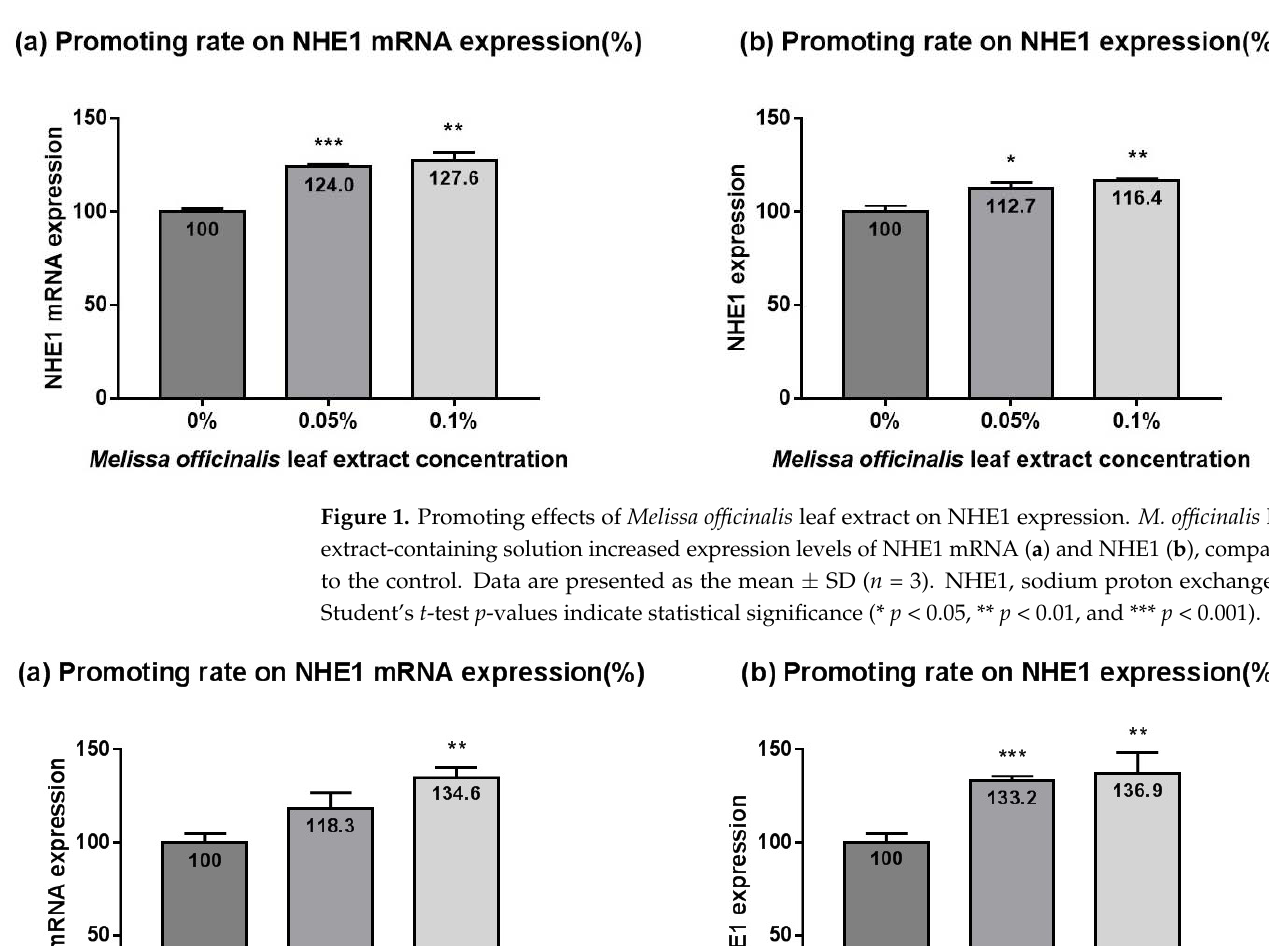
Figure 1. Promoting effects of Melissa officinalis leaf extract on NHE1 expression. M. officinalis leaf extract ‐ containing solution increased expression levels of NHE1 mRNA ( a ) and NHE1 ( b ), com ‐ pared to the control. Data are presented as the mean ± SD ( n = 3). NHE1, sodium proton exchanger 1. Student’s t ‐ test p ‐ values indicate statistical significance (* p < 0.05, ** p < 0.01, and *** p < 0.001).